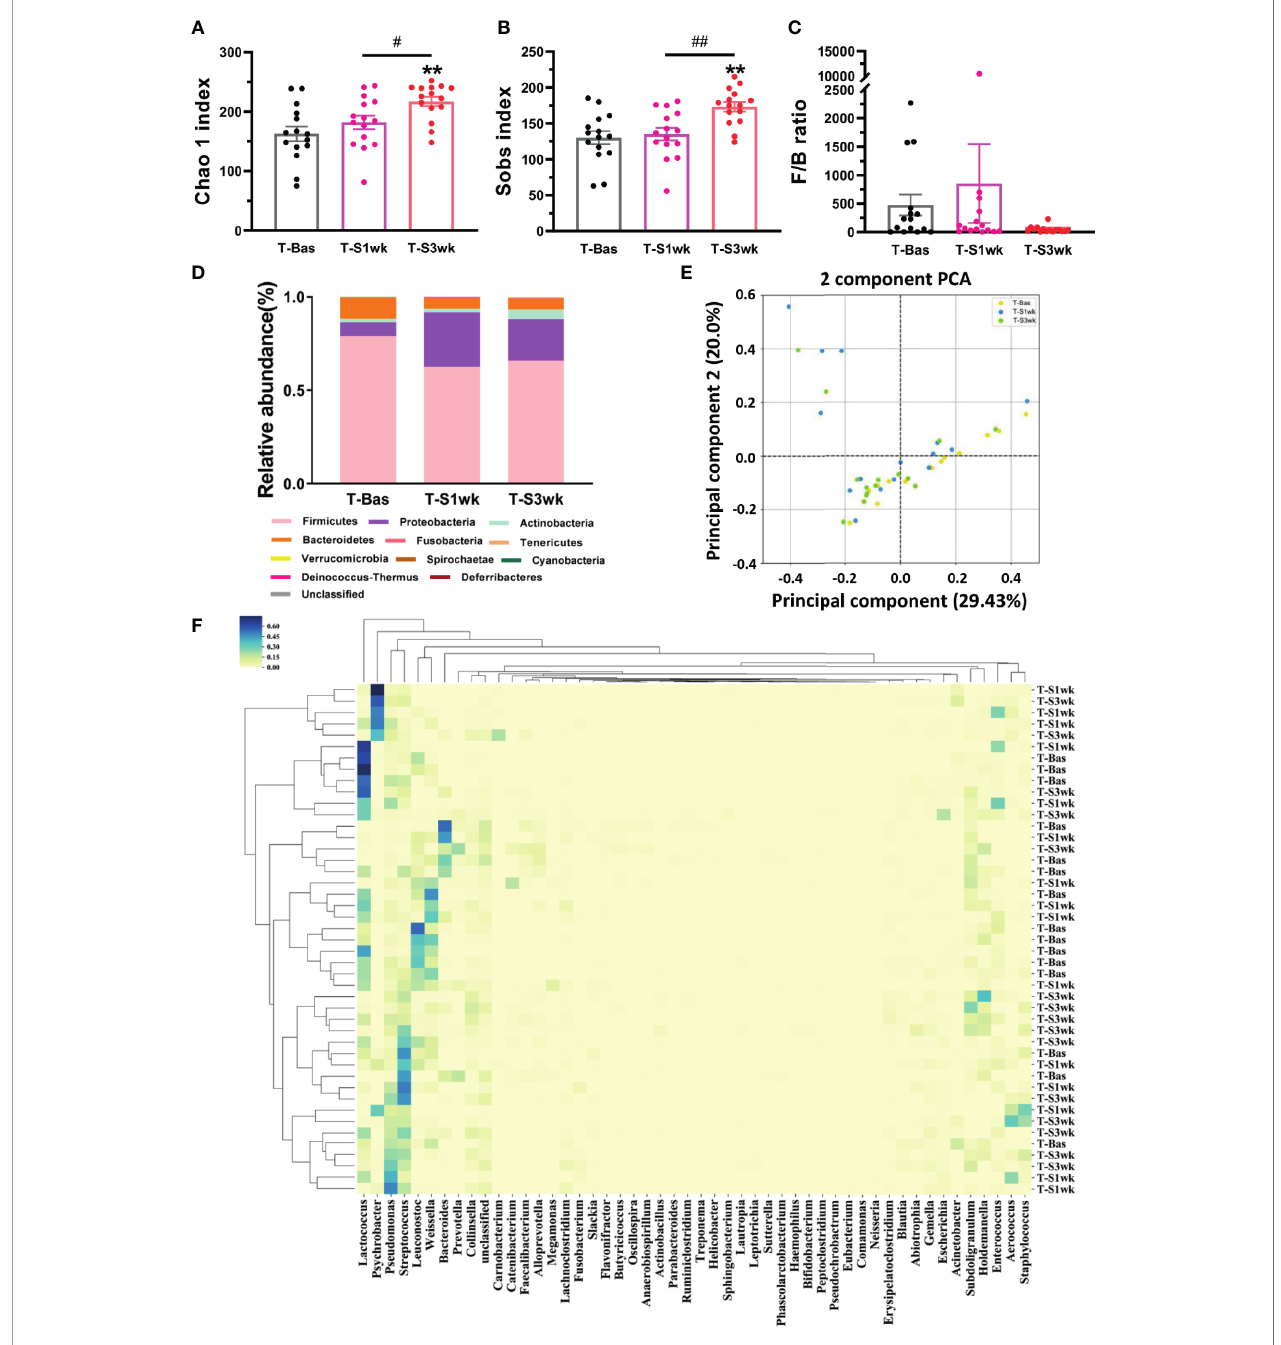
FIGURE 2 | The variations of gut microbiota composition and biodiversity after staying up late for 21 days in tree shrews. (A) The Chao 1 index signi fi cantly increased at T-S3wk in light-induced stress phase (LSD Post Hoc: compared with T-Bas, p = 0.001, compared with T-S1wk, p = 0.026). (B) The Sobs index showed an increased level at T-S3wk in light-induced stress phase (LSD Post Hoc: compared with T-Bas, p = 0.001, compared with T-S1wk, p = 0.002). (C) The ratio of Firmicutes -to- Bacteroidetes (F/B ratio) increased at T-S1wk but decreased at T-S3wk. (D) The median relative abundance of the Firmicutes and Bacteroidetes decreased but that of the Proteobacteria and Actinobacteria increased. (E) The PCA on gut microbiota community of the tree shrews at baseline was different from that in the third week after stress. Each dot stands for one sample. (F) The heat map presented the microbial distribution of the tree shrews at baseline was different from that in the fi rst week and the third week after stress. N = 15. Error bars show the SEM. **means compared with control in baseline phase, **p <0.01. # means compared between each other in stress phase, #p <0.05, ##p